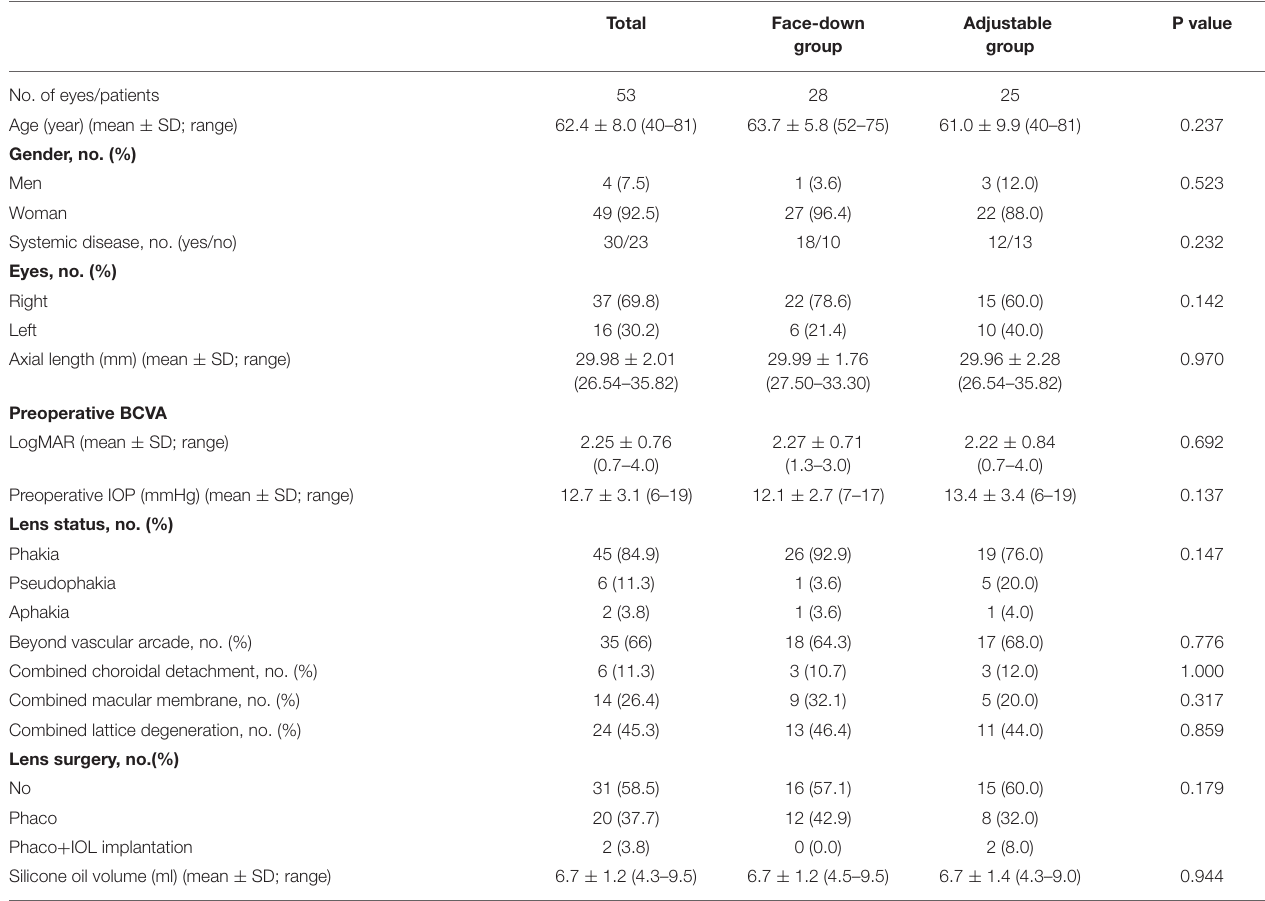
TABLE 1 | The baseline parameters, status, and surgical procedure of patients.